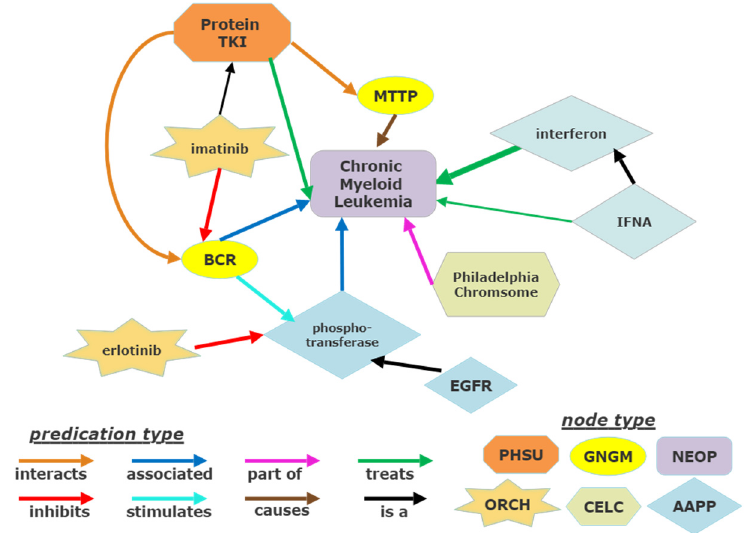
Figure 2. How to read a knowledge graph derived from text-mined biomedical relationships. Text is mined from 30+ million PubMed articles to make a heterogeneous information network, or knowledge graph, of relationships. This example is a highly pruned (>99.9% pruned) subgraph of the larger knowledge graph. The actual knowledge graph is so large and intertwined that it would be completely intractable to the human eye. The shapes are called nodes and represent concepts from biomedical literature. The type of shape represents the ontology of the node, called a node type. Example node types shown include pharmacological substance (PHSU), gene or genome (GNGM), neoplasm (NEOP), organic chemical (ORCH), cell component (CELC) and amino acid, peptide, or protein (AAPP). The ontology for node types and predication types is dictated by the Unified Medical Language System (UMLS). The lines represent predication types, or relationships, between the nodes. The different colors represent a different predication type. The line thickness represents the degree weighted frequency of the relationship in the corpus. Relationships are read in head-PREDICATION-tail format. Examples: imatinib-IS A-protein TKI and imatinib-INHIBITS- BCR.